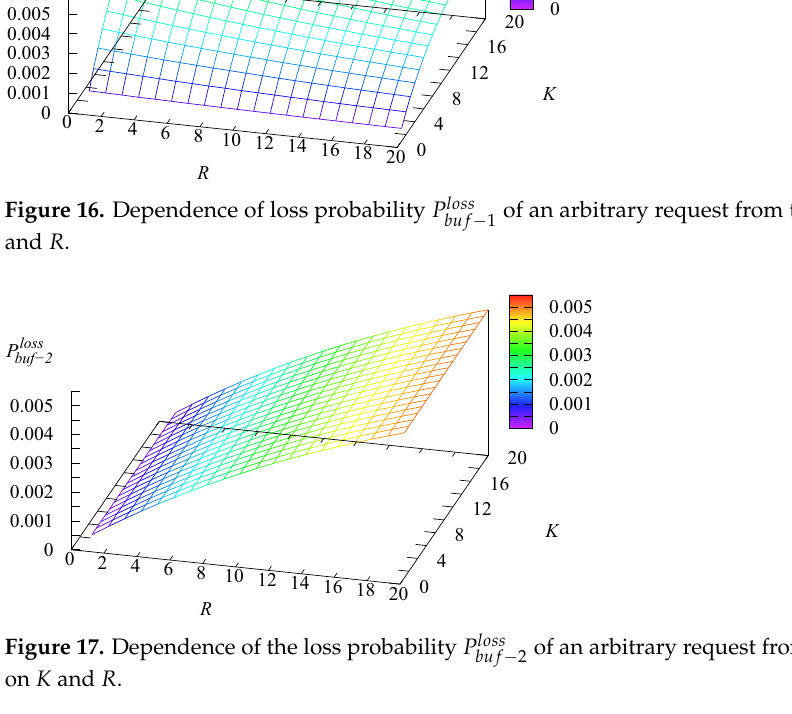
of an arbitrary request from the second buffer buf − 2